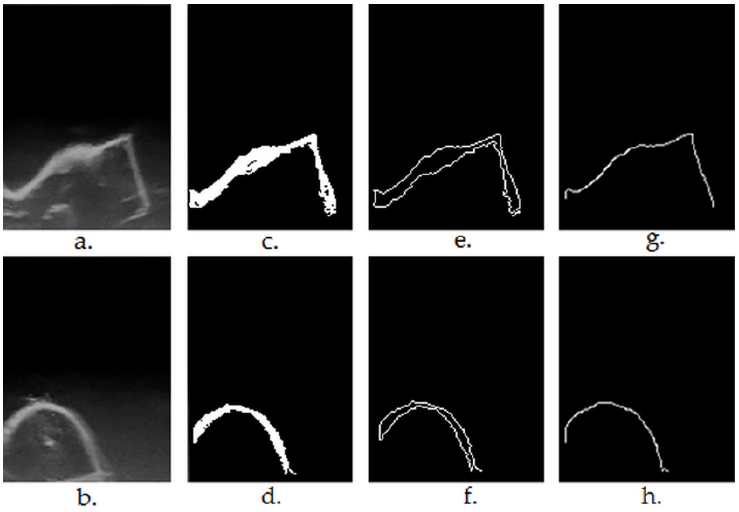
Figure 3. ( a , b )—original ultrasound frames in greyscale (( a )—first premolar, regulated shaped object having plane surfaces, right angles; ( b )—lateral incisor); ( c , d )—results after region growing- based segmentation and morphological post-processing (Algorithms 1–3); ( e , f )—results after contour extraction ( findExternalContours function in Algorithm 4); ( g , h )—results after upper contour (envelope) extraction (Algorithm